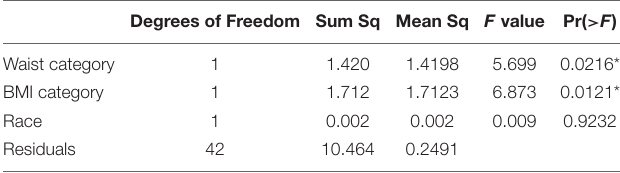
TABLE 3 | Result summary of the ANCOVA model for premenstrual food